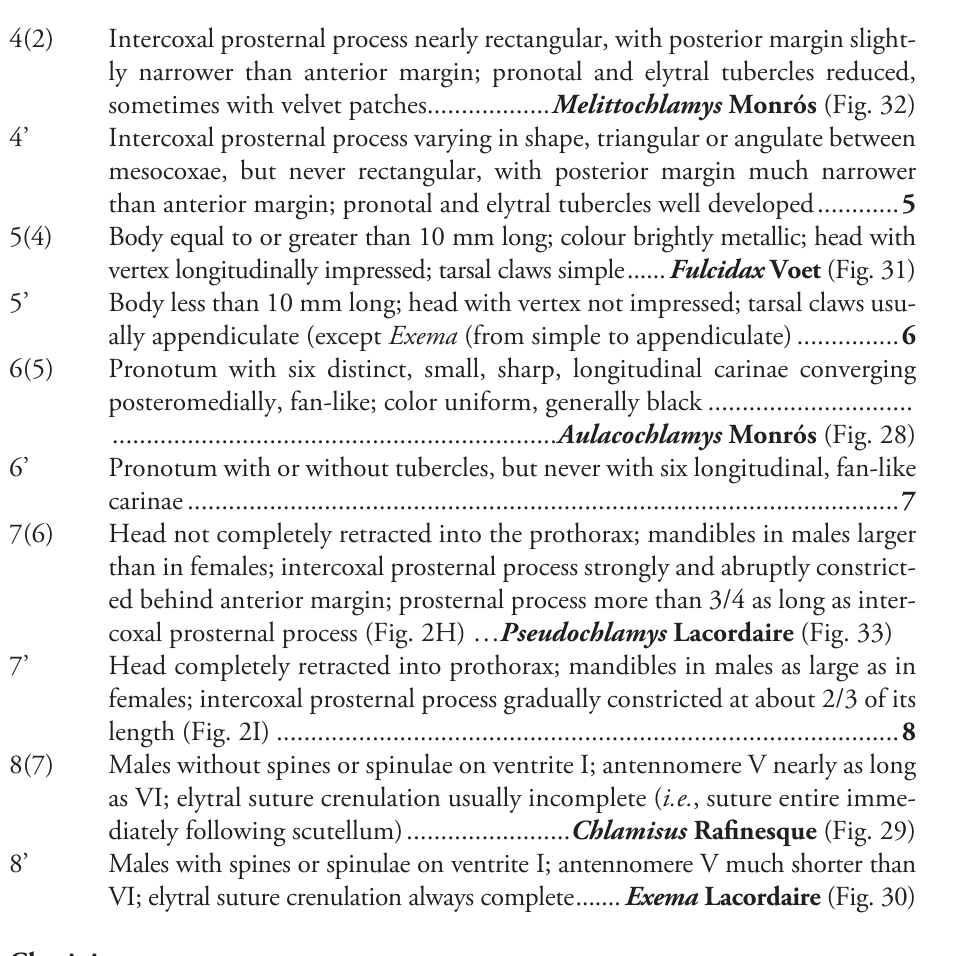
4(2) Intercoxal prosternal process nearly rectangular, with posterior margin slight- ly narrower than anterior margin; pronotal and elytral tubercles reduced, sometimes with velvet patches.................. Melittochlamys Monrós (Fig. 32) 4’ Intercoxal prosternal process varying in shape, triangular or angulate between mesocoxae, but never rectangular, with posterior margin much narrower than anterior margin; pronotal and elytral tubercles well developed ............ 5 5(4) Body equal to or greater than 10 mm long; colour brightly metallic; head with vertex longitudinally impressed; tarsal claws simple ...... Fulcidax Voet (Fig. 31) 5’ Body less than 10 mm long; head with vertex not impressed; tarsal claws usu- ally appendiculate (except Exema (from simple to appendiculate) ............... 6 6(5) Pronotum with six distinct, small, sharp, longitudinal carinae converging